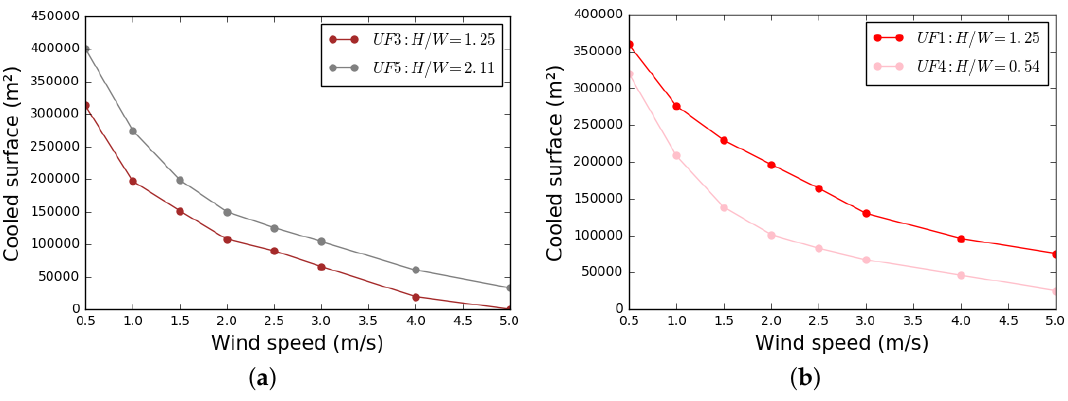
Figure 8. Influence of wind speed on the cooled surface for different aspect ratio values. ( a ) For high building density; ( b ) For low building